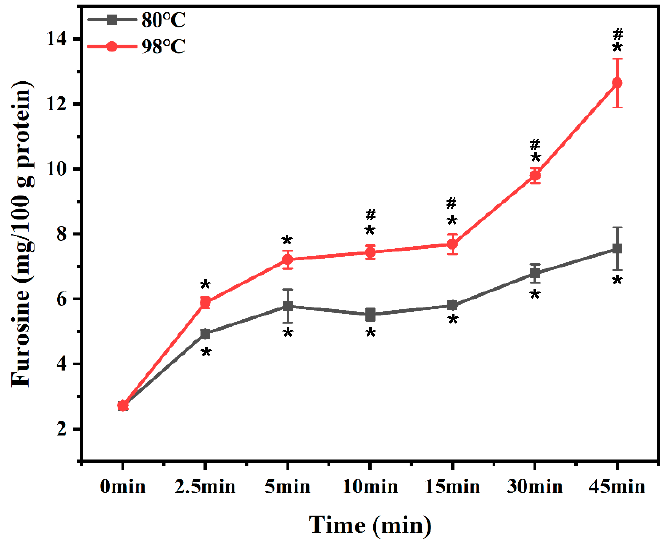
Figure 2. Changes in furosine content of myofibrillar protein and glucose (MPG) under different heating conditions (80 °C and 98 °C, 0 − 45 min). Error bars indicate standard deviation (n = 3). Samples with * p < 0.05 indicate significant differences at different heating times (compared with 0 min). Samples with # p < 0.05 indicate significant differences between 80 °C and 98 °C.